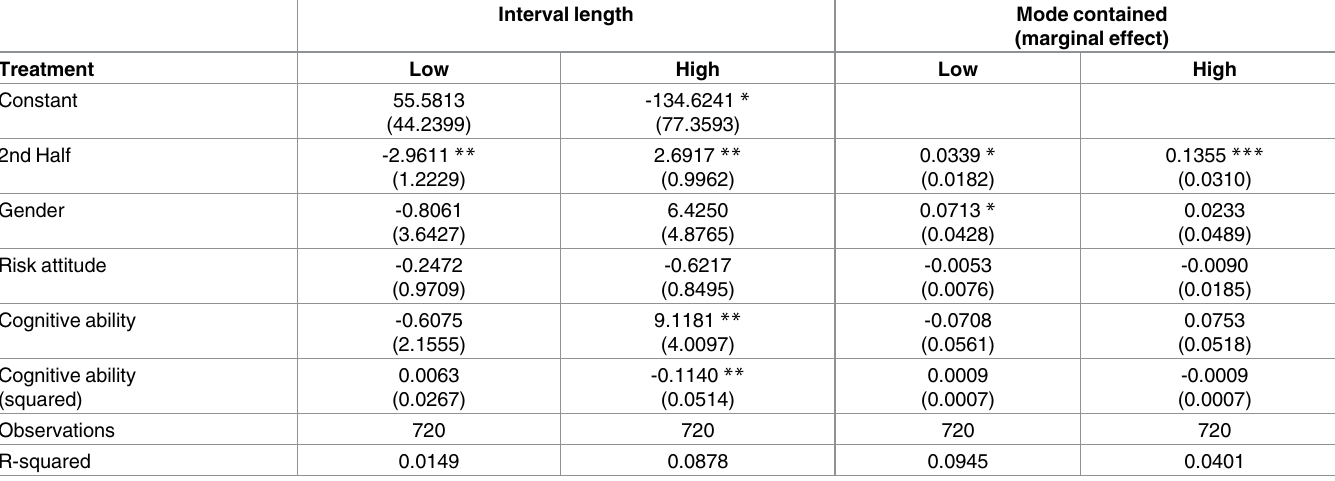
Table 2. Interval length and whether the mode is contained in the interval against individual